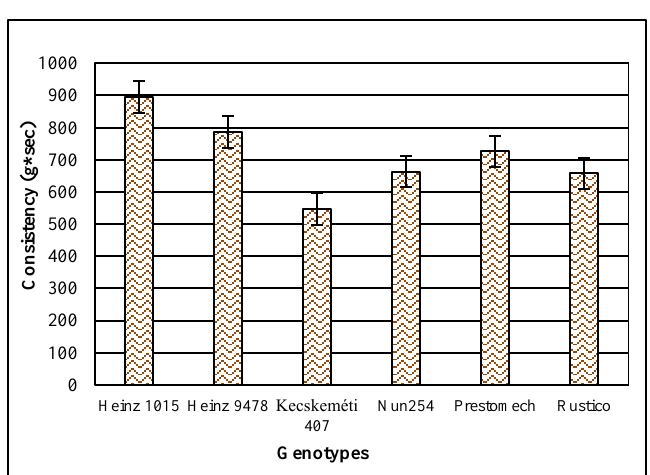
Figure 6. Consistency of tomato juice.